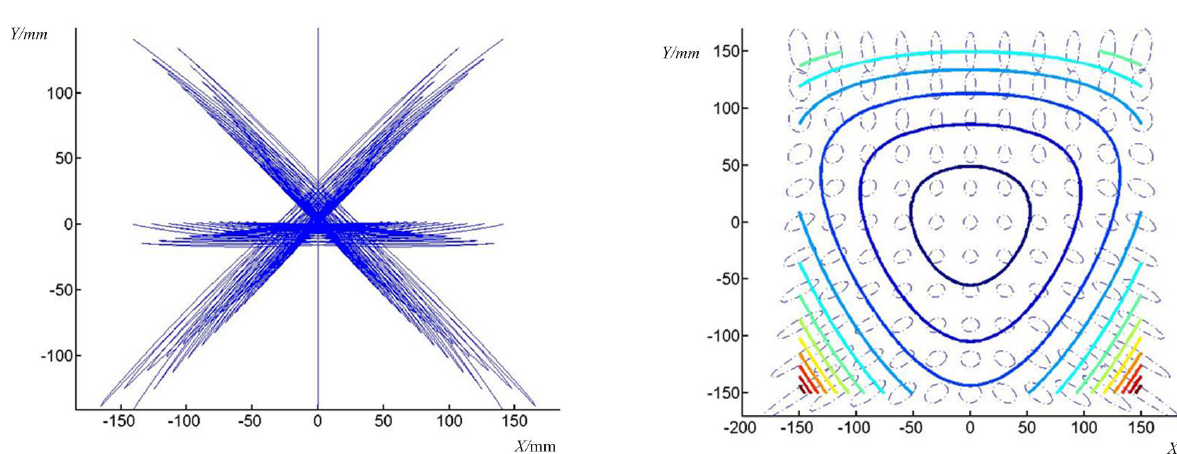
Figure 18. Stiffness contours of the platform in case 3.